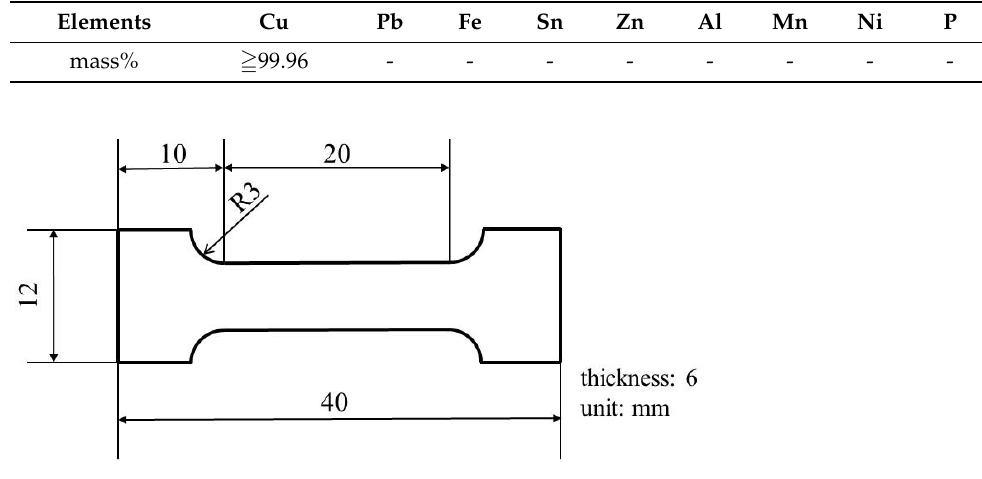
Figure 1. Shape and dimensions of C1020 specimen.